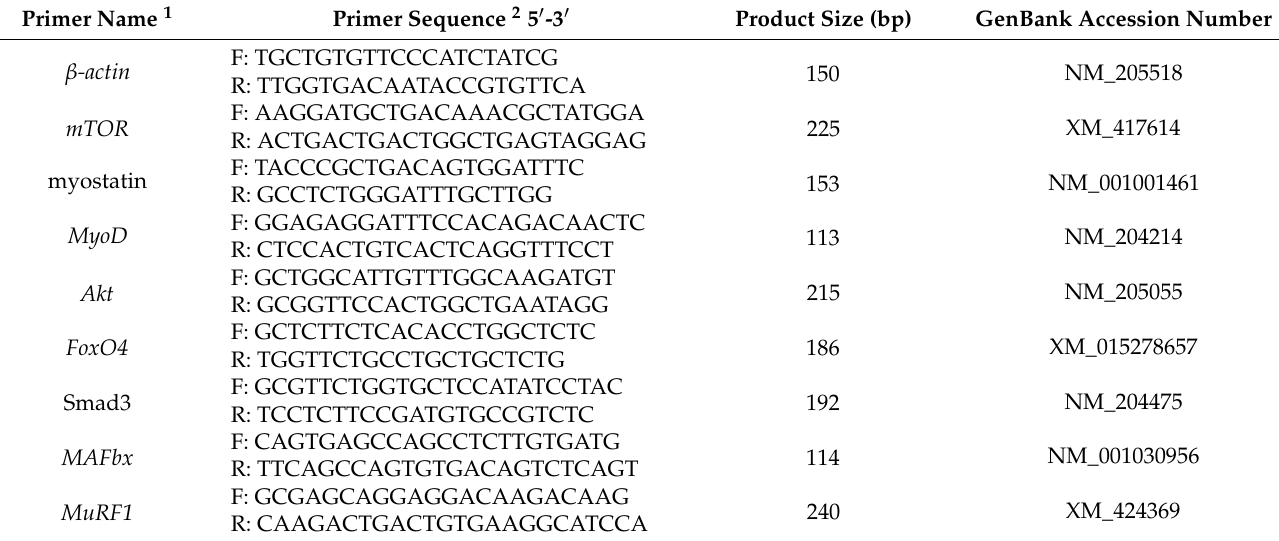
Table 1. Primers used for quantitative RT-PCR.